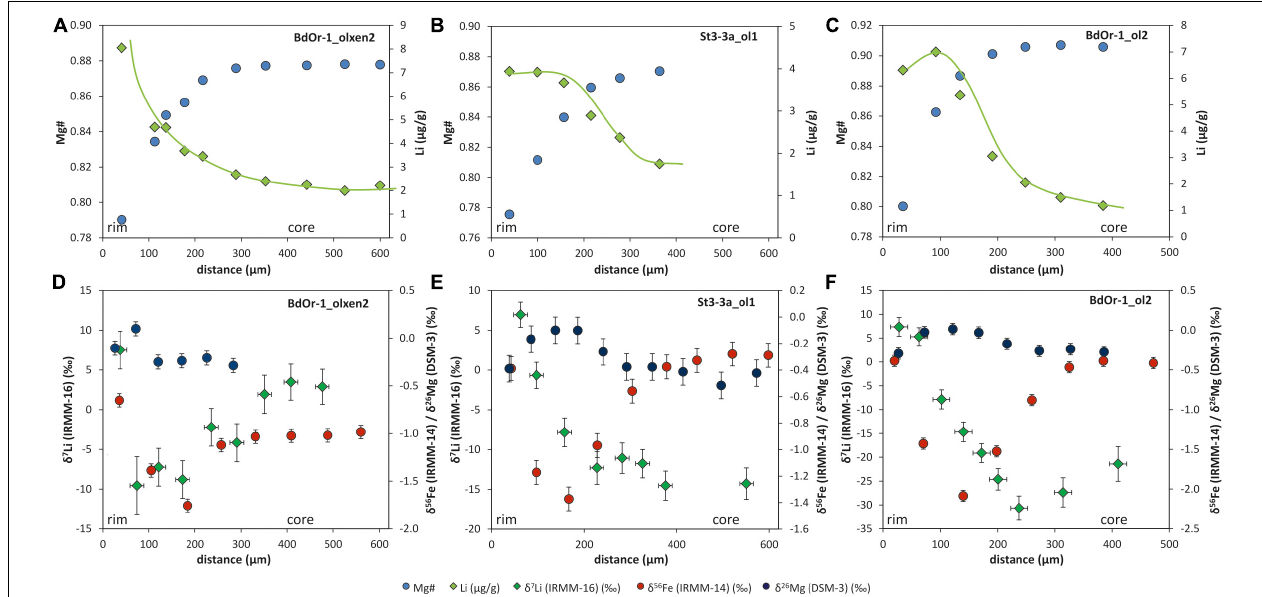
FIGURE 2 | Mg–Fe and Li concentration zoning for (A) BdOr1_olxen2, (B) St3-3a_ol1, and (C) BdOr-1_ol2. Li concentration zoning with best-fit shape of the concentration profile (green lines) and Mg# are reversely correlated Mg, Fe, and Li isotope profiles for (D) BdOr1_olxen2, (E) St3-3a_ol1, and (F) BdOr-1_ol2. The isotope profiles show a coupling between Li and Mg–Fe diffusion, however, with an offset toward a wider zoning for Li for most olivines. Horizontal error bars display the spot size for laser ablation ( ∼ 30 µ m) and vertical error bars represent the analytical uncertainty (2 σ ) during one sample-standard-bracketing for Li and 2SD during one analytical session for Mg and Fe [values for Mg and Fe isotopes are taken from Oeser et al. (2015)].